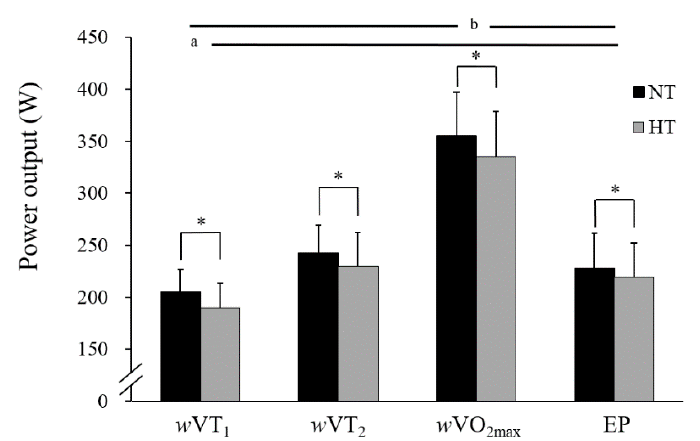
Figure 1. Comparison of the differences among parameters of environments and exercise intensities under thermoneutral temperature (NT) and/or high temperature (HT). * Significant difference between temperature environments ( p < 0.05). a w VT 1 was significantly different from the other intensities in NT or HT ( p < 0.05). b w VO 2max was significantly different from the other intensities in NT or HT ( p < 0.05).